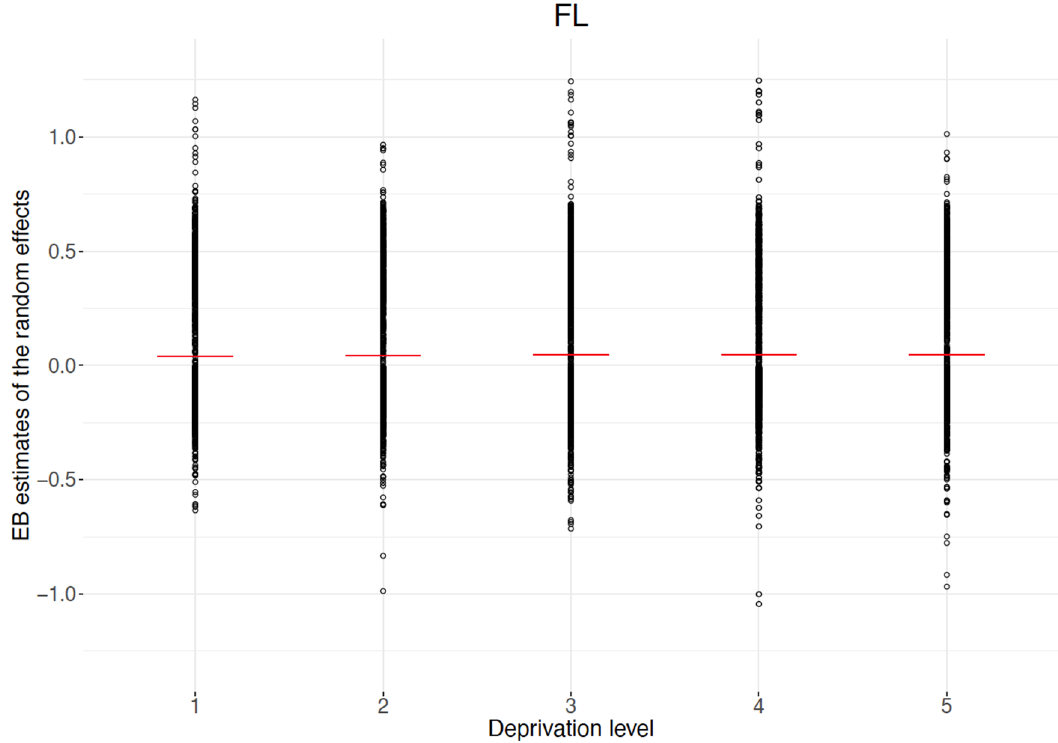
Figure A6. Empirical Bayes estimates of the random effect of LSOA from the excess mortality hazard model for patients